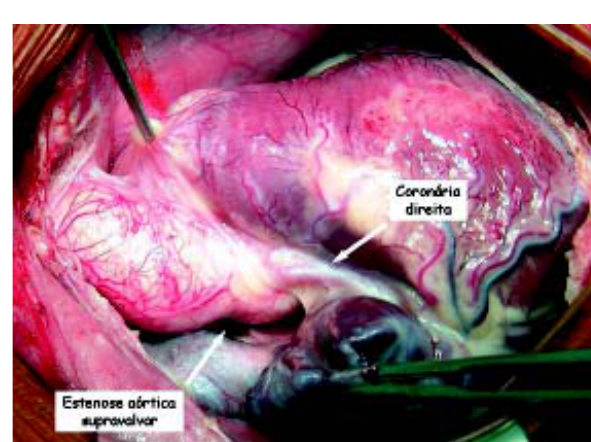
Fig. 2 – Aspecto externo da região estenótica na aorta ascendente